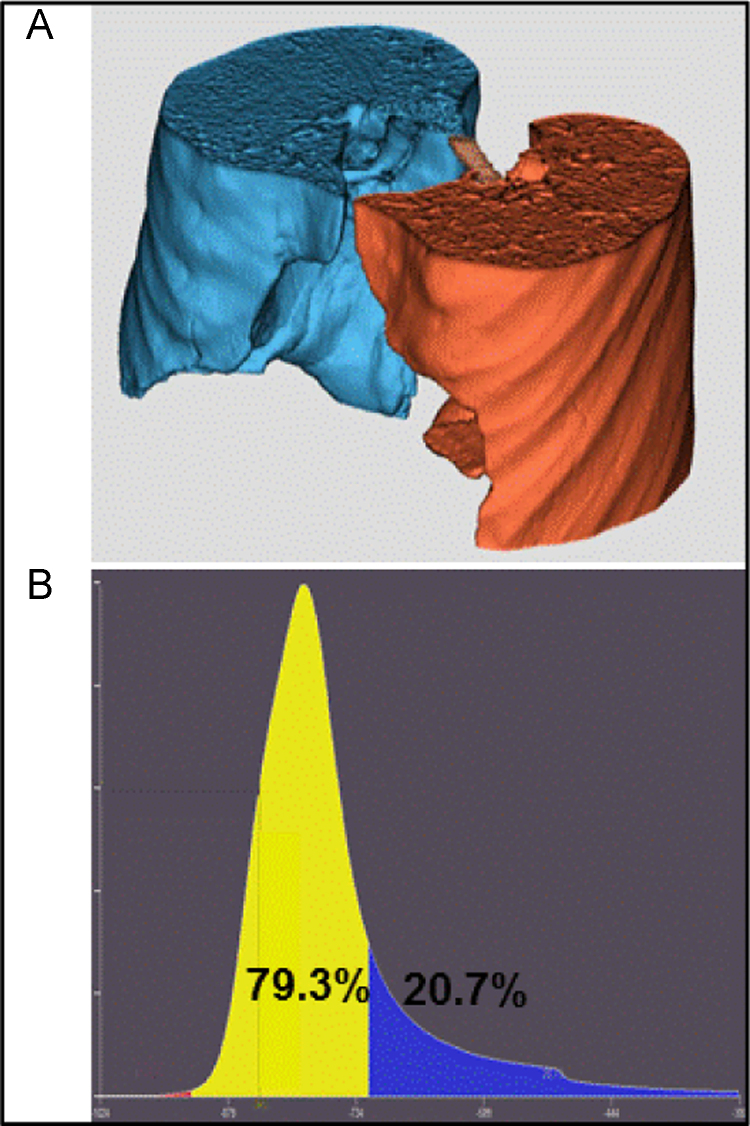
How to perform quantitative assessment of Ground-glass opacification (A) The software performs automated segmentation of pulmonary tissue adjacent to the heart. (B) An example of a histogram of the relative frequency of HU values of the automated lung segmentation (excluding all values above −300 HU) shows the percentage of lung tissue with high pulmonary attenuation density > −720 HU (= high pulmonary density ratio) in blue color. (For interpretation of the references to color in this figure legend, the reader is referred to the web version of this article).